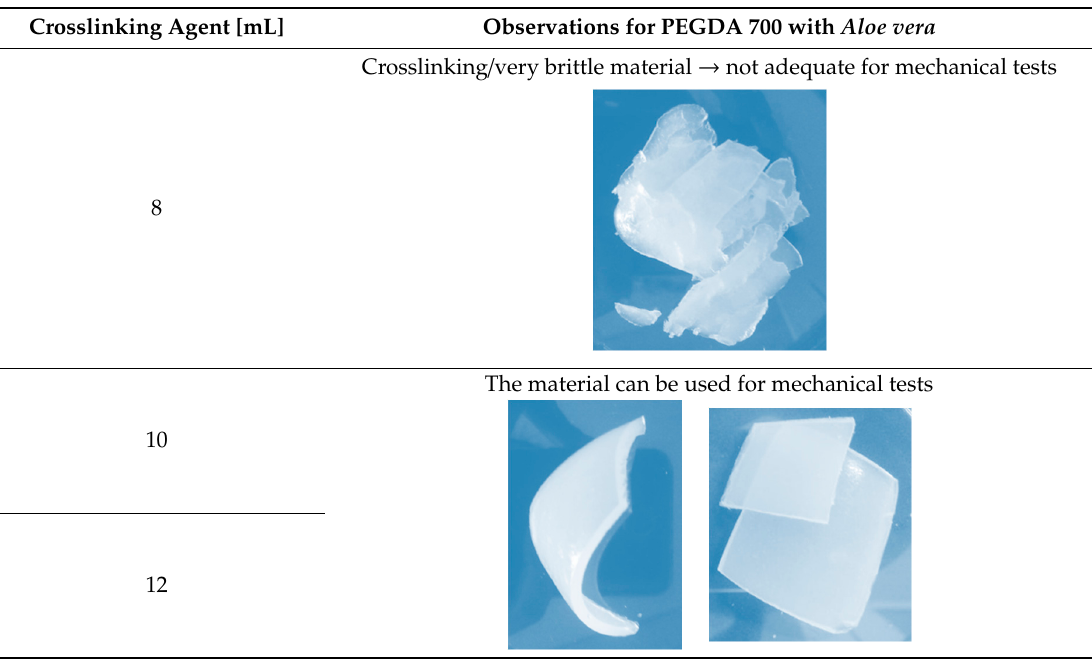
Table 5. Observation of the course of crosslinking process of hydrogels containing Aloe vera juice obtained using different crosslinkers with different molecular weights and amounts.